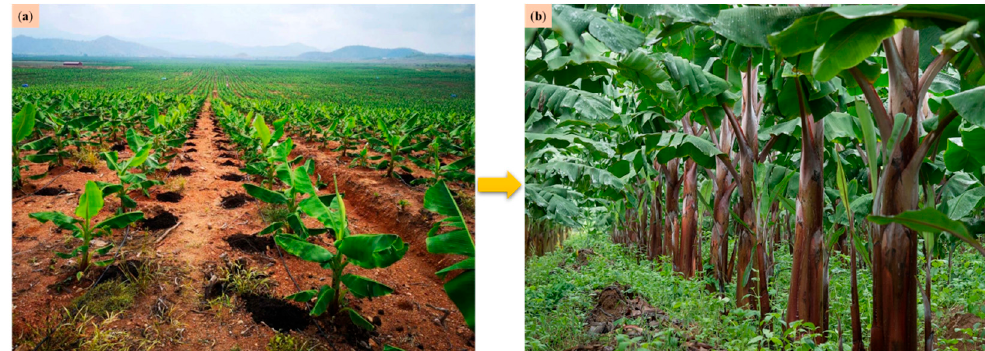
Figure 1. The planting and growth of banana plants in a new banana orchard. ( a ) Planting of banana seedlings; ( b ) growing banana plants in an orchard.